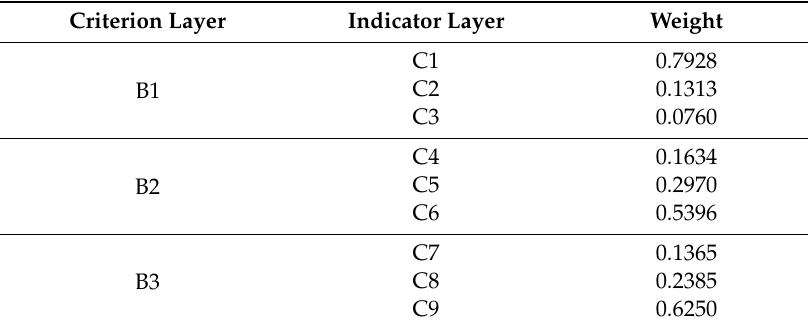
Table 4. Weight coe ffi cient of all factors in the hierarchy structure.